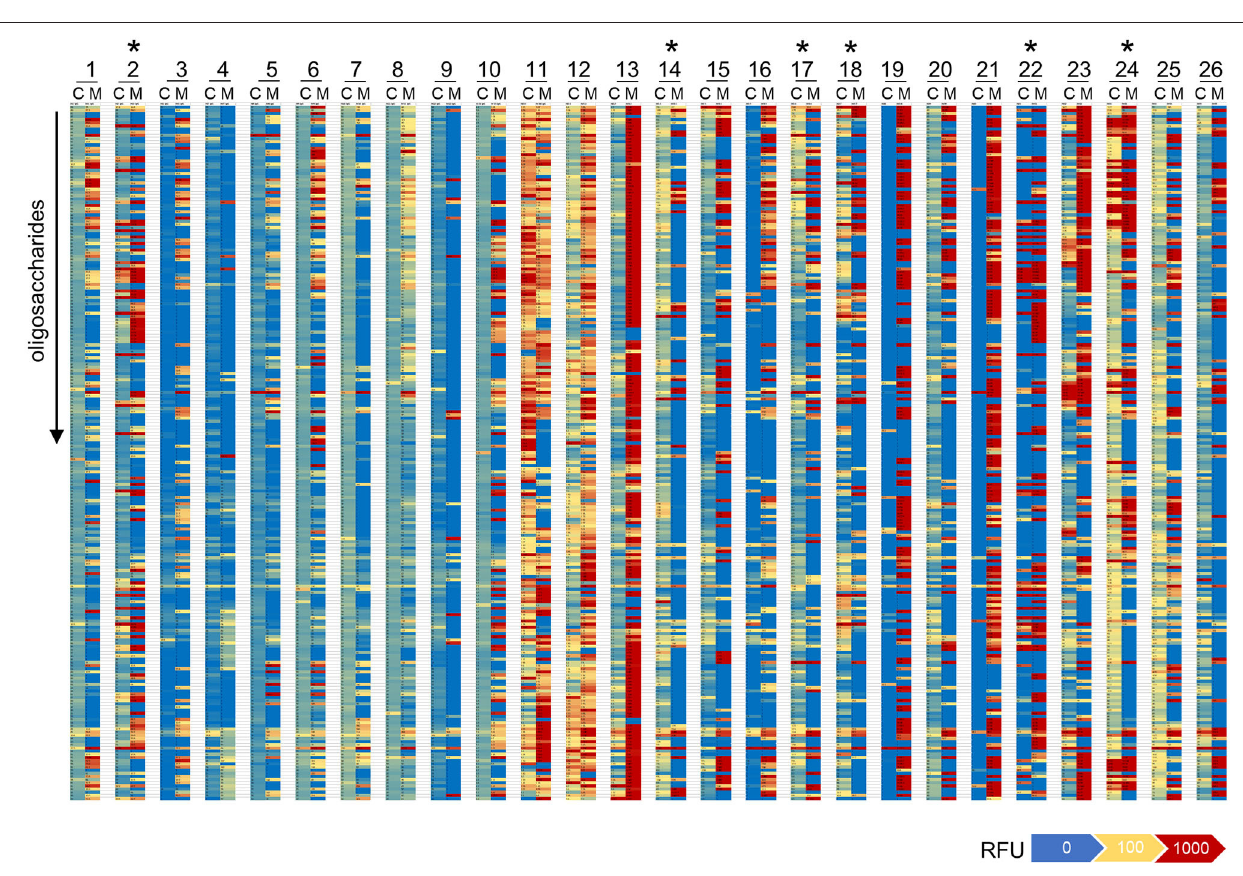
FIGURE 4 | Repertoires of carbohydrate-specific IgG only partially overlap in matched maternal blood and cord blood. Heatmaps representing the profile of carbohydrate-specific IgG in 26 matched pairs of cord blood (C) and maternal blood (M). Pairs with visible overlaps in the IgG repertoires are indicated by an asterisk.